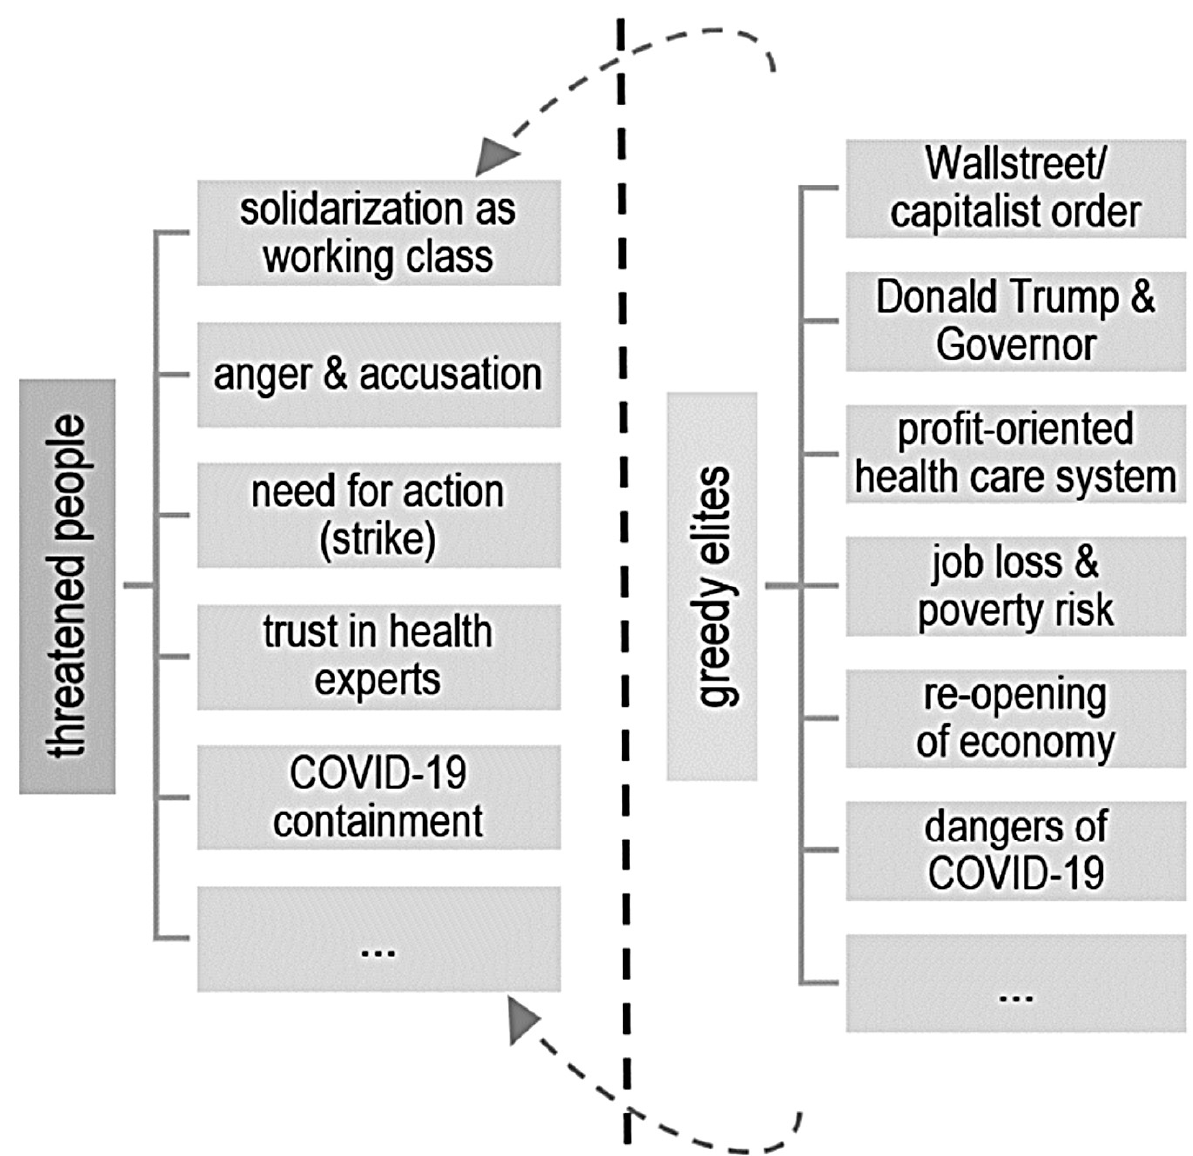
Figure 6. Antagonistic struggles in discourse (own